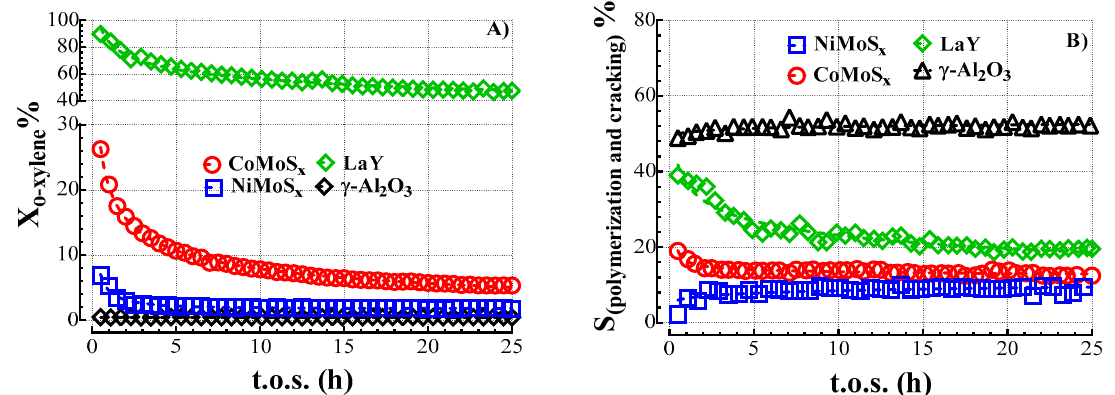
Figure 3. Catalytic results: ( A ) conversion of o-xylene and ( B ) selectivity to polymerization and cracking products.